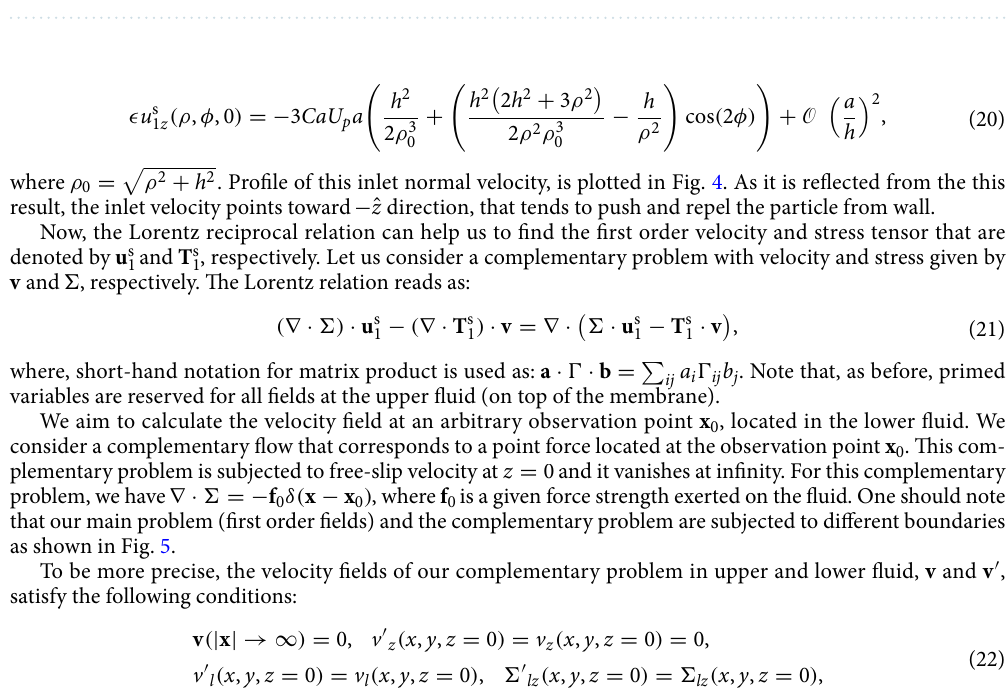
Figure 4. Boundary velocity u s 1 z ( x , y